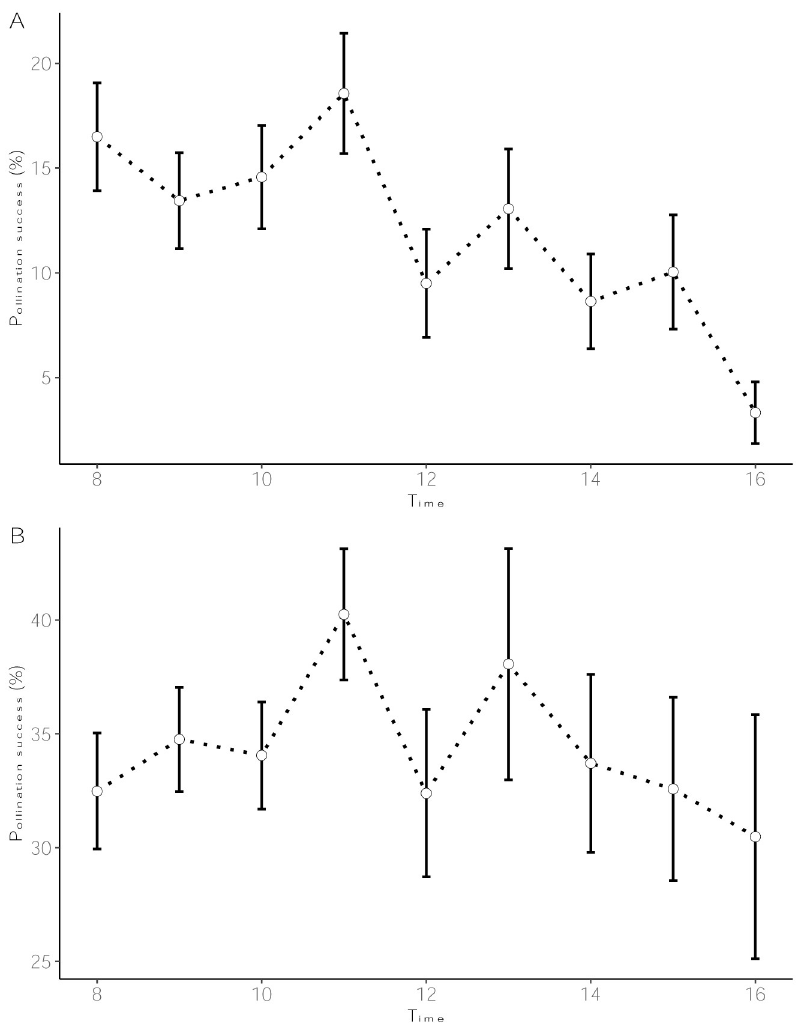
Fig 3. Pollination success across crossing hours: (A) D . alata , (B) D . rotundata